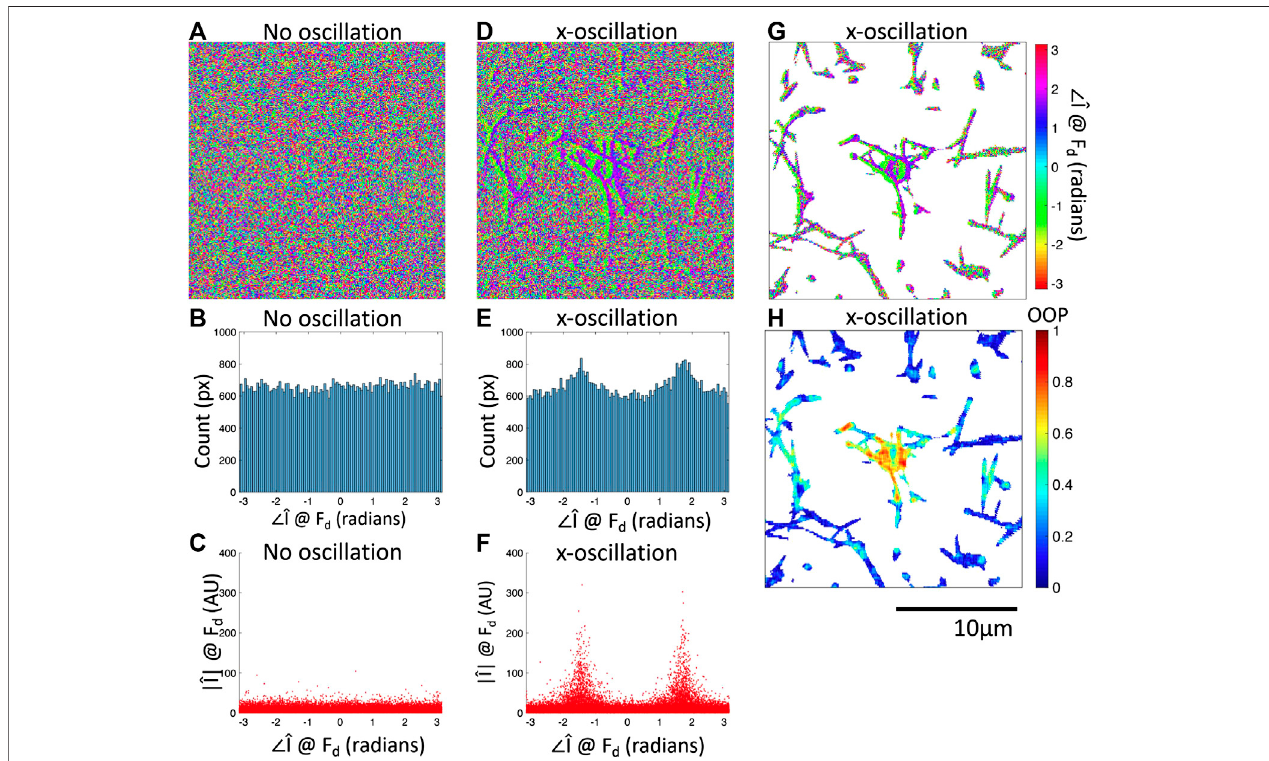
FIGURE 3 | Fourier phase images at F d identify subsets of fi bers which oscillate with the bead. (A) Phase image at F d with no applied oscillation. (B) Histogram of thephaseimageinpanelAshowinguniformlydistributedphase. (C) Comparisonofphaseandmagnitudeforeachpixelwithnoappliedoscillation. (D) Phaseimageat F d with oscillation applied in the x -direction. The two sides of the bead and some fi bers show a distinct pattern. (E) Histogram of the phase image in panel D showing two peaks in the distribution of the phase. (F) Comparison of phase and magnitude for each pixel with oscillation applied in the x -direction. Pixels with increased magnitude tend toward one ofthepeaks in thephase distribution. (G) Phaseimage at F d from panel (D) displaying only pixels covering the fi ber network. (H) Local OOP ofthephaseimage from panel (D) displaying only pixels covering the fi ber network. Local OOPiscomputed foreach seven bysevenpixelregion. Theorganized regions have high OOP and the unorganized regions have low